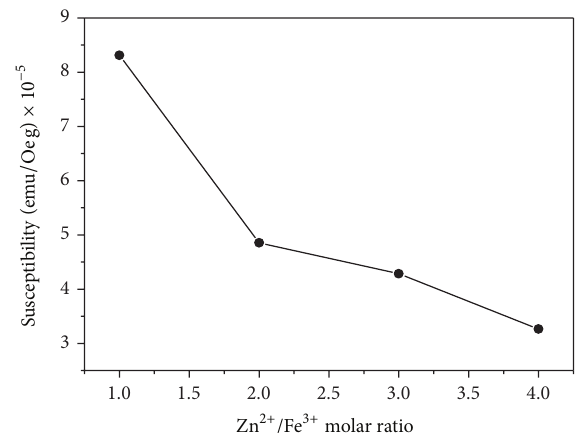
Figure 6: Susceptibility as function of Zn 2+ /Fe 3+ molar ratio for calcined